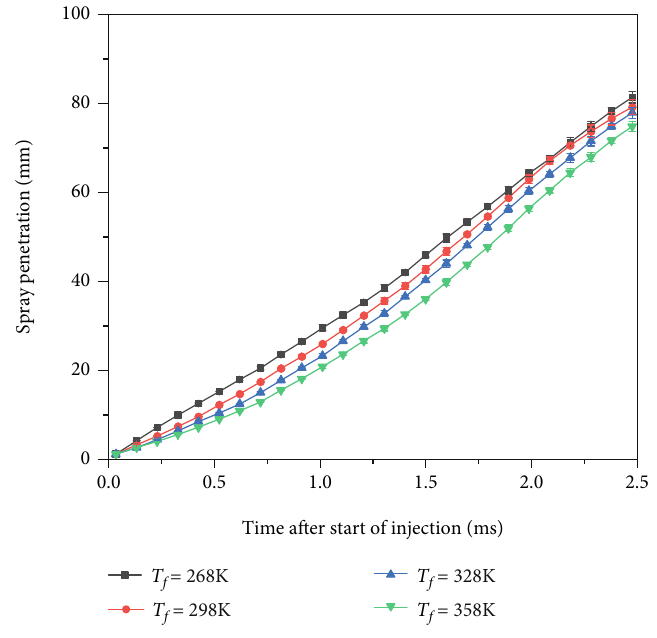
= 0 : 8MPa , Δ T = 4 : 0 ms ). f f